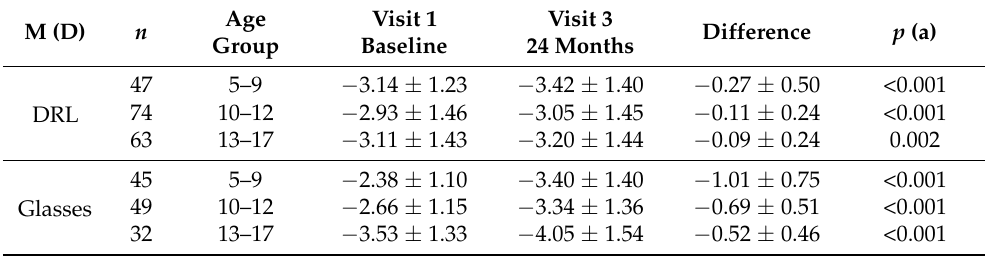
Figure 2. Myopia progression retention rate values for the M component after 12 months and after 24 months of treatment between treatments. Table 6. Data from the longitudinal study at 24 months of treatment in the comparison between DRL and glasses for the M component of